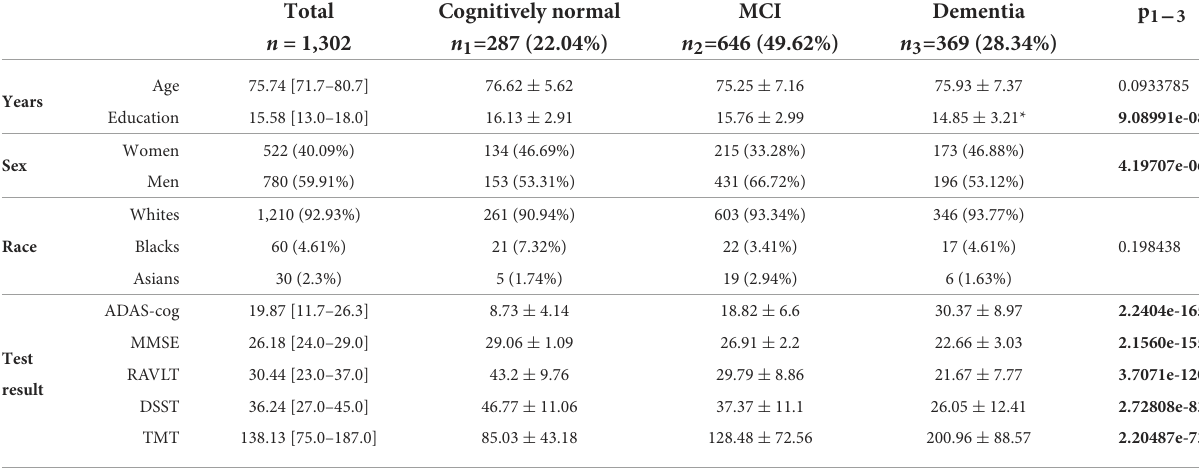
TABLE 1 Demographics, cognitive performance in study